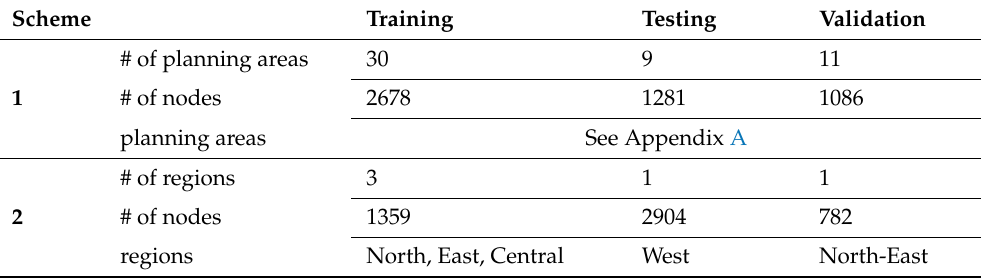
Table 9. Sizes of the training, testing and validation set in the two data split schemes. The lists of planning areas in each set are shown in Appendix